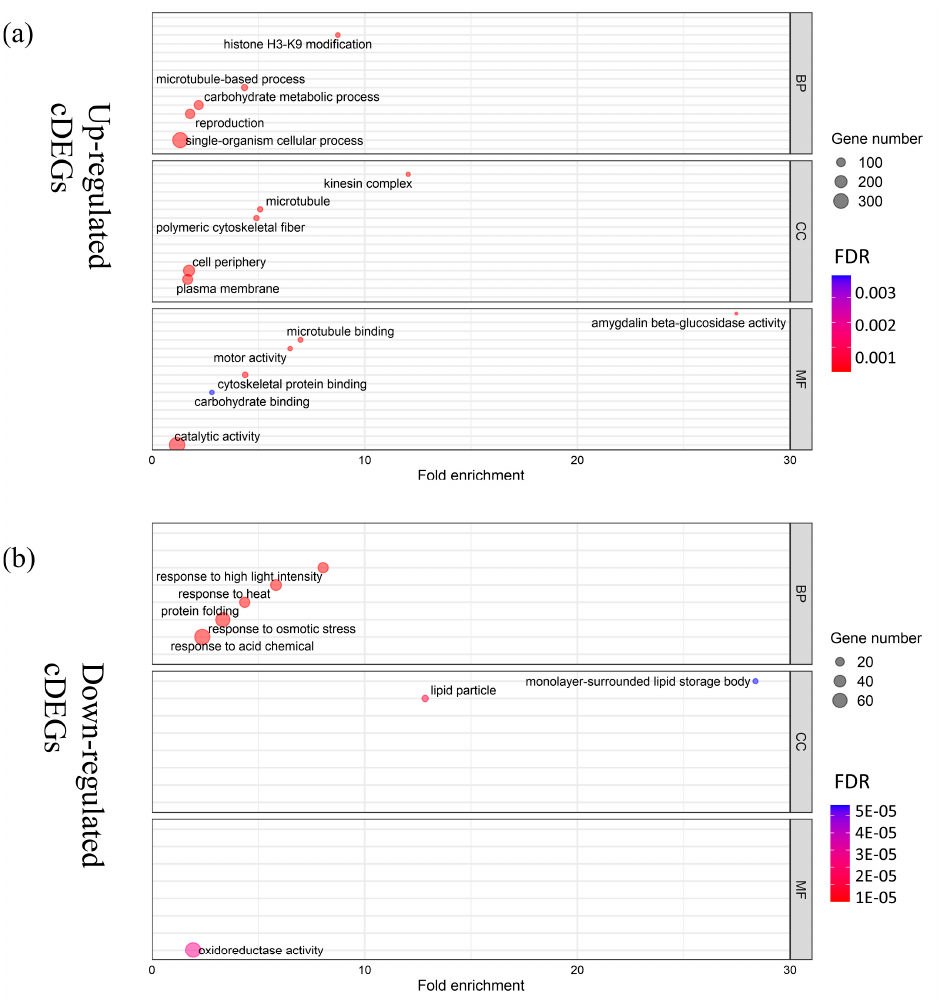
Figure 4. GO enrichment analysis of common DEGs (cDEGs) with upregulated ( a ) and downregulated ( b ) expressions. The size of the dots and color scale represent the number of cDEGs in the GO terms and the significance level (FDR), respectively.